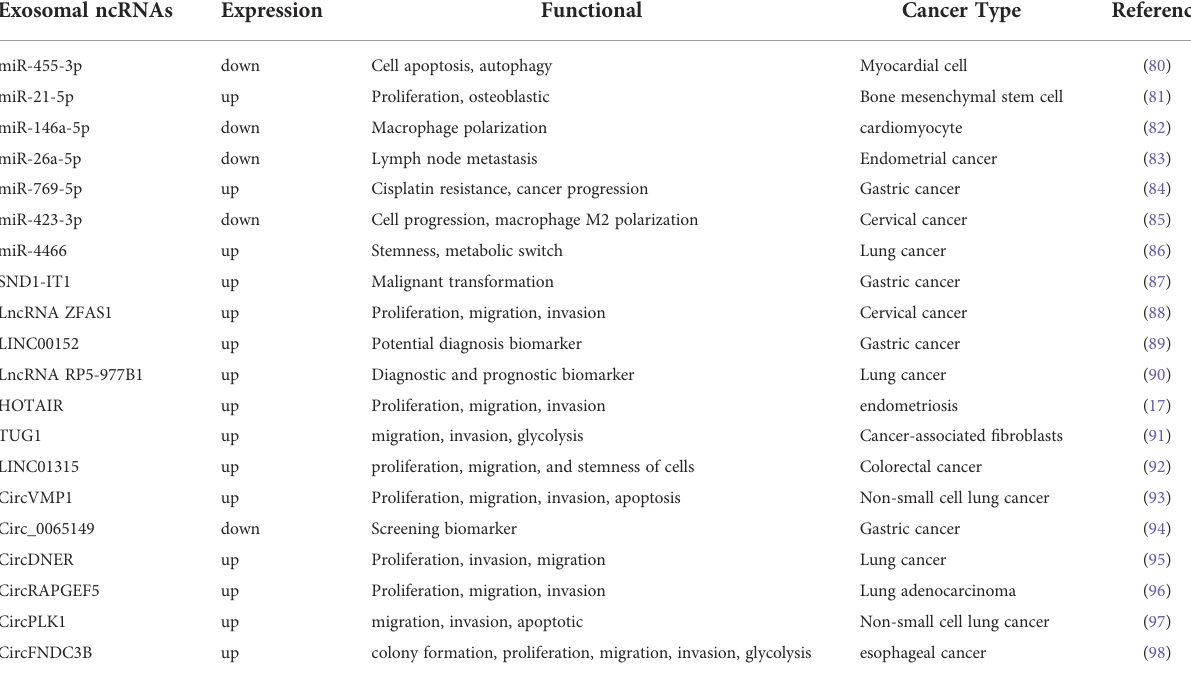
TABLE 3 ncRNAs in